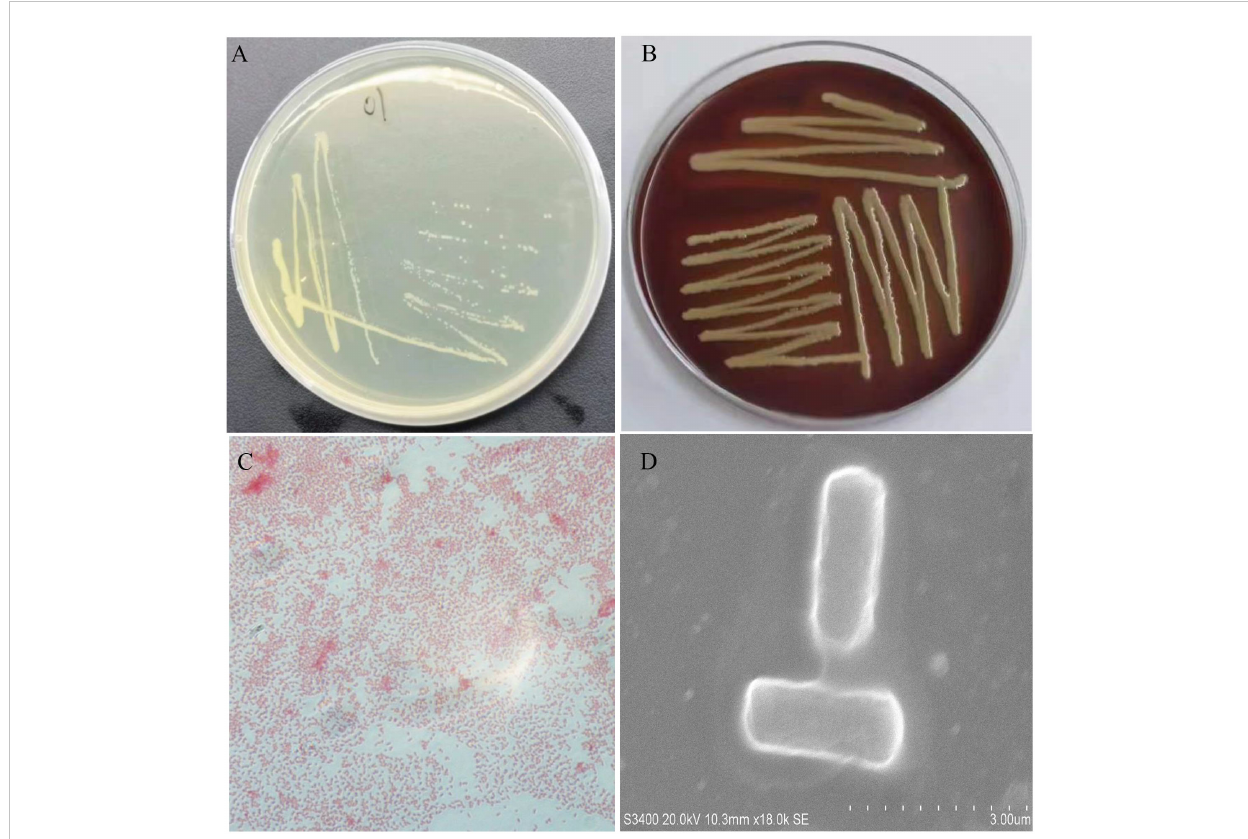
FIGURE 2 Morphological features of NFEM01 isolated from the occurrence of bullfrog disease cultured in Guangxi. (A) NFEM01 single colonies, (B) the hemolytic activity of the strain was determined according to the hemolytic area around the colony, (C) Gram stained under a light microscope, and (D) individual cells under a scanning electron microscope.